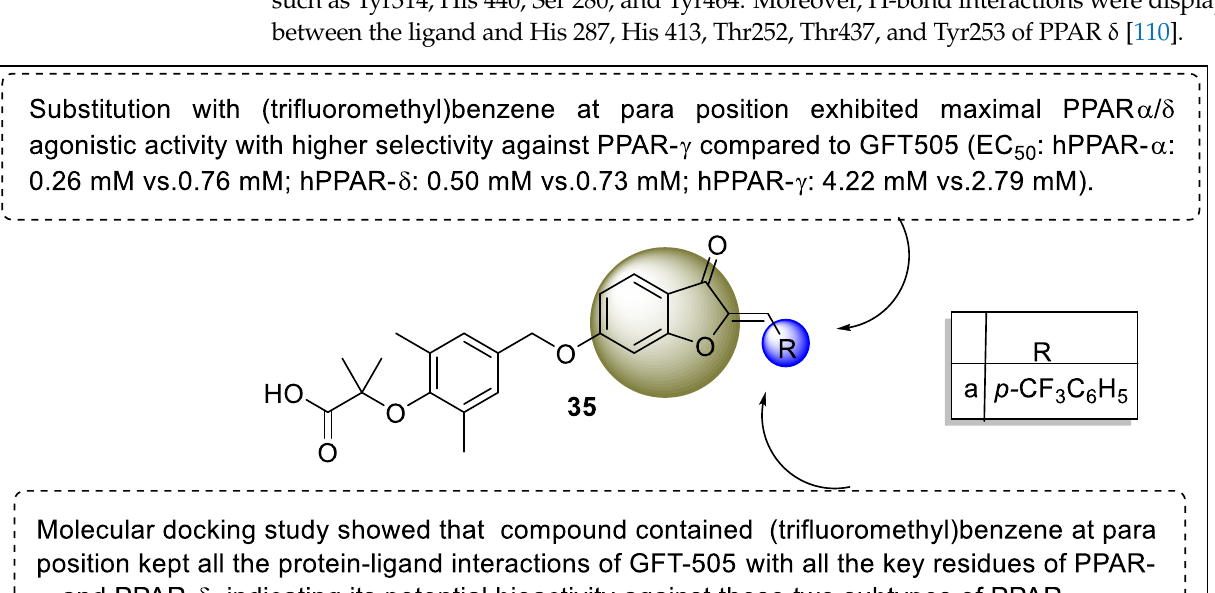
Figure 38. Structural activity relationship of Furan hybrids ( 34 ) as potent PPAR ligands.